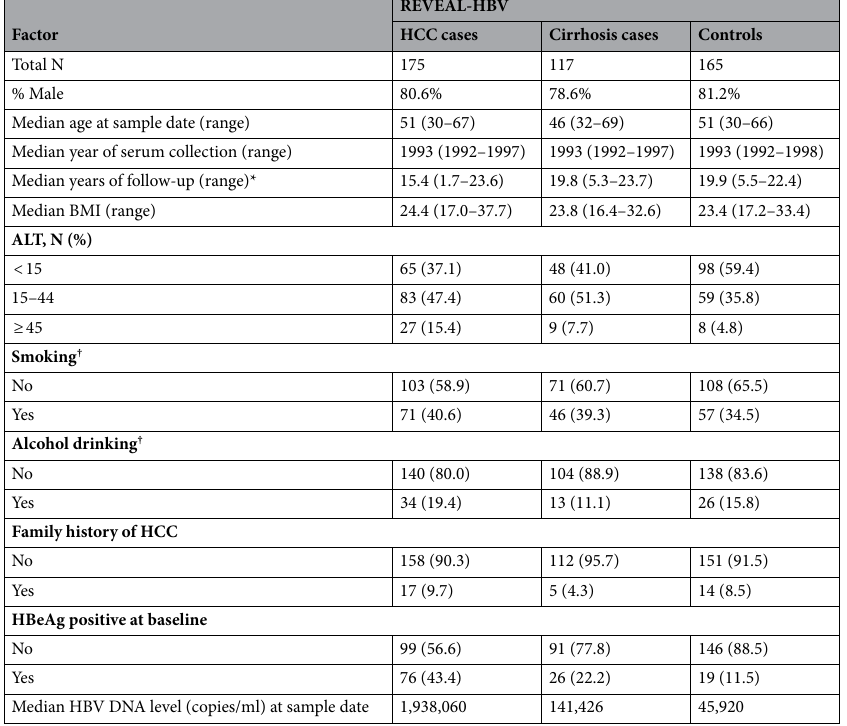
Table 1. Participants characteristics. *Time from entry to HCC diagnosis, death, or end of study (December 31, 2011), whichever came first. † Numbers do not add to total due to missing values.